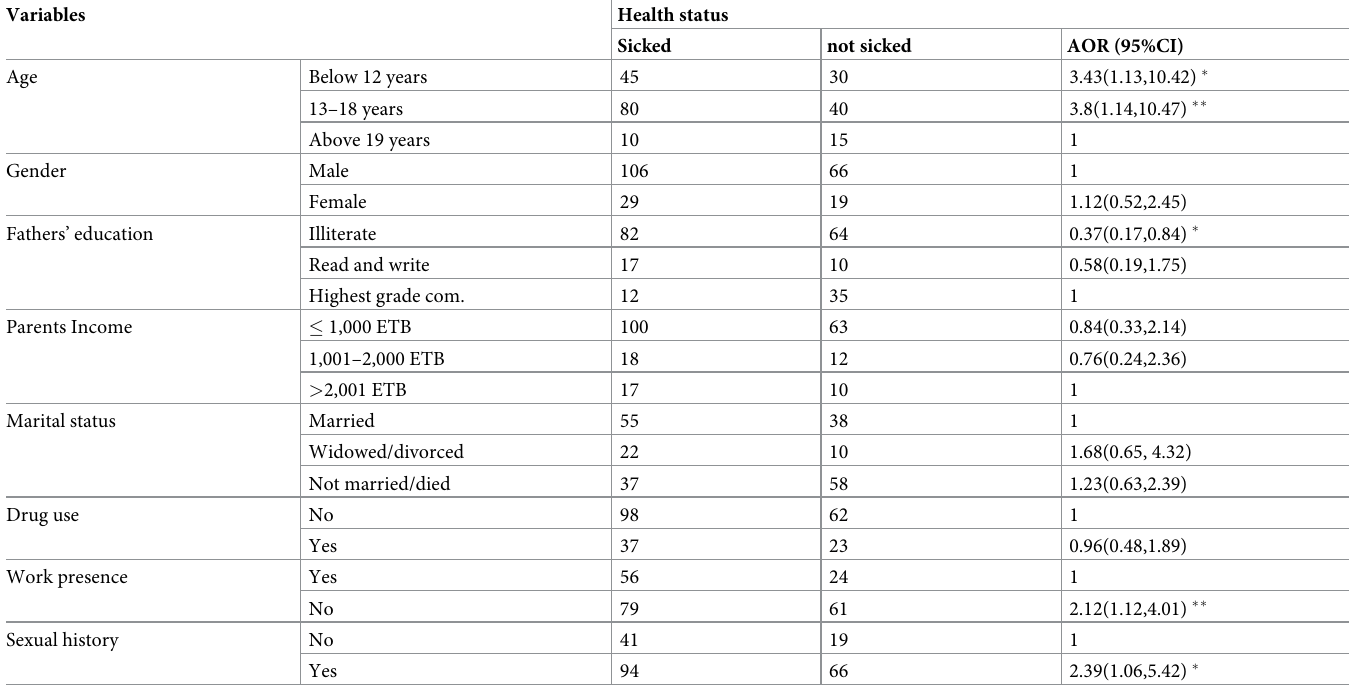
Table 6. Factors associated with the health status of the streets in Harar, Ethiopia (n =